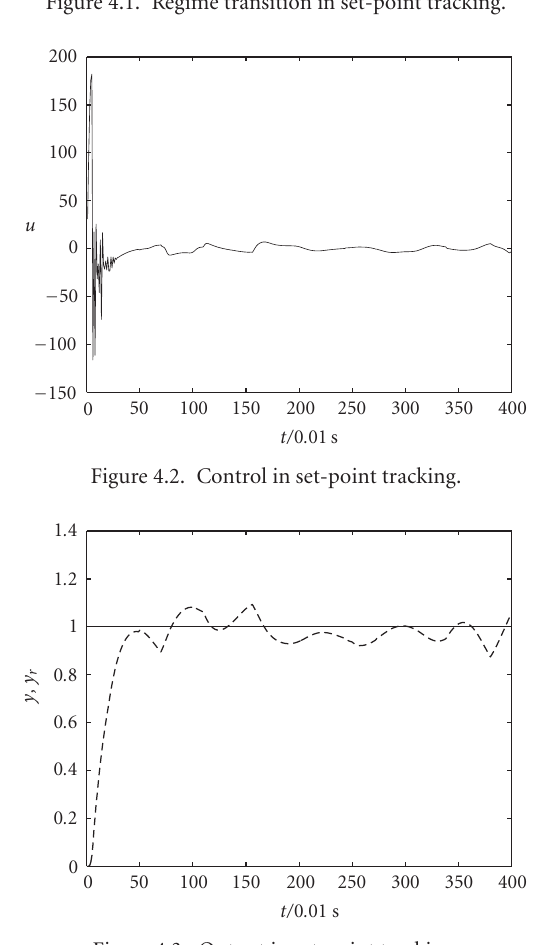
Figure 4.3. Output in set-point